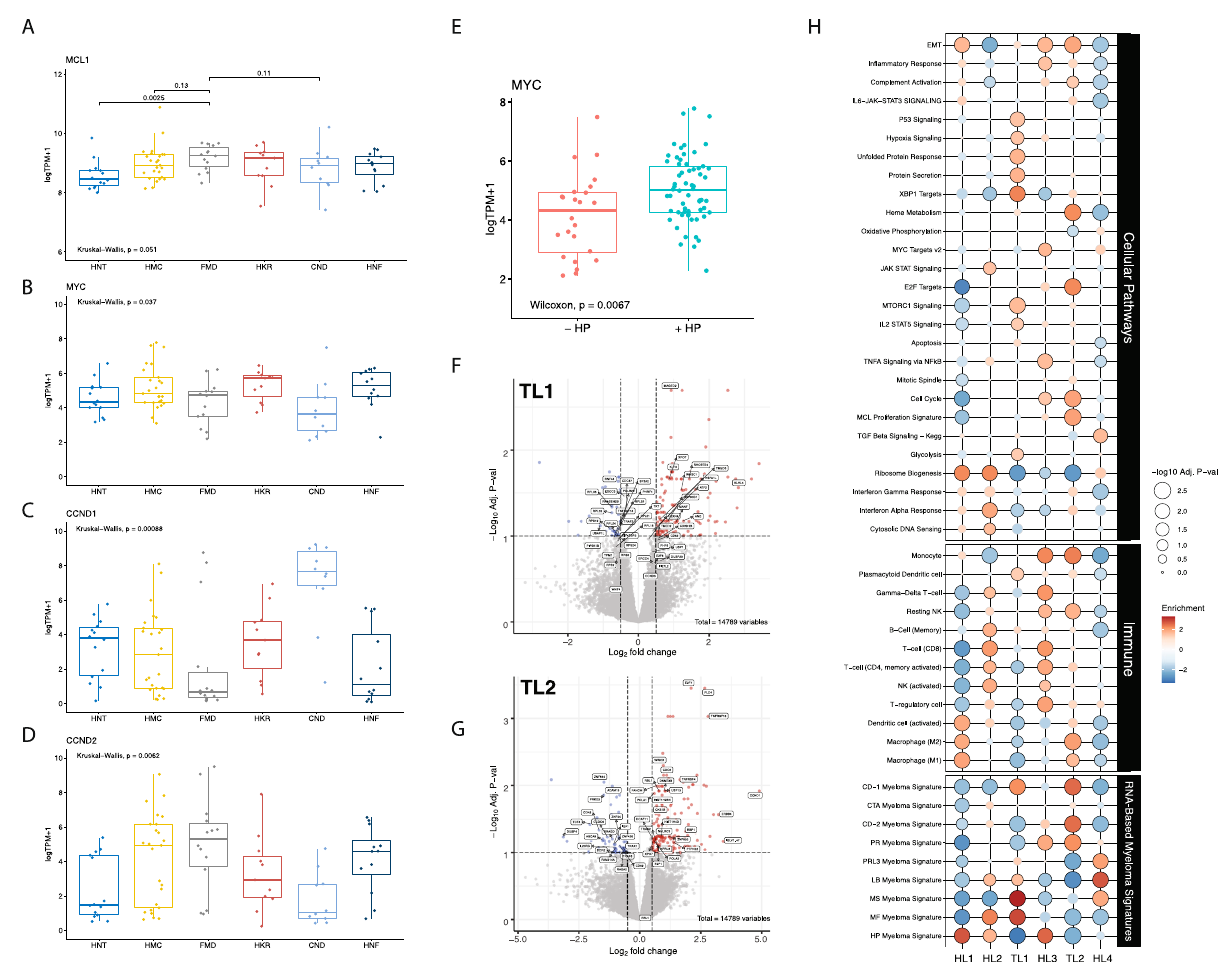
Fig. 2 Differential gene expression and gene set enrichment analysis for tumors from the six genetic subtypes ( n = 89). A – D Comparison of gene expression levels of MCL1, MYC , CCND1 , and CCND2 among the six genetic subtypes. Two-sided p value derived from Kruskal – Wallis test. E Comparison of expression levels of MYC oncogene expression between the two non hyperdiploid ones (-HL) and the four hyperdiploid ( + HL) subtypes. Two-sided p -value was calculated using the Wilcoxon rank-sum test. Expression is measured by the log 2 value of transcript per million of each gene (log 2 TPM + 1). Boxplots representing median, and interquartile range, whiskers representing fi rst, and fourth quartile. F Volcano plot showing fold changes for genes differentially expressed between tumors of TL1 subtype and the other subtypes. G Volcano plot showing fold changes for genes differentially expressed between tumors of TL2 subtype and the other subtypes. X axis = Log 2 fold change, Y axis = − log 10 adjusted p value. H Gene set enrichment analysis of different molecular and oncogenic pathways (top), immune cell signatures (middle), and MM-speci fi c signatures (bottom) among the six genetic